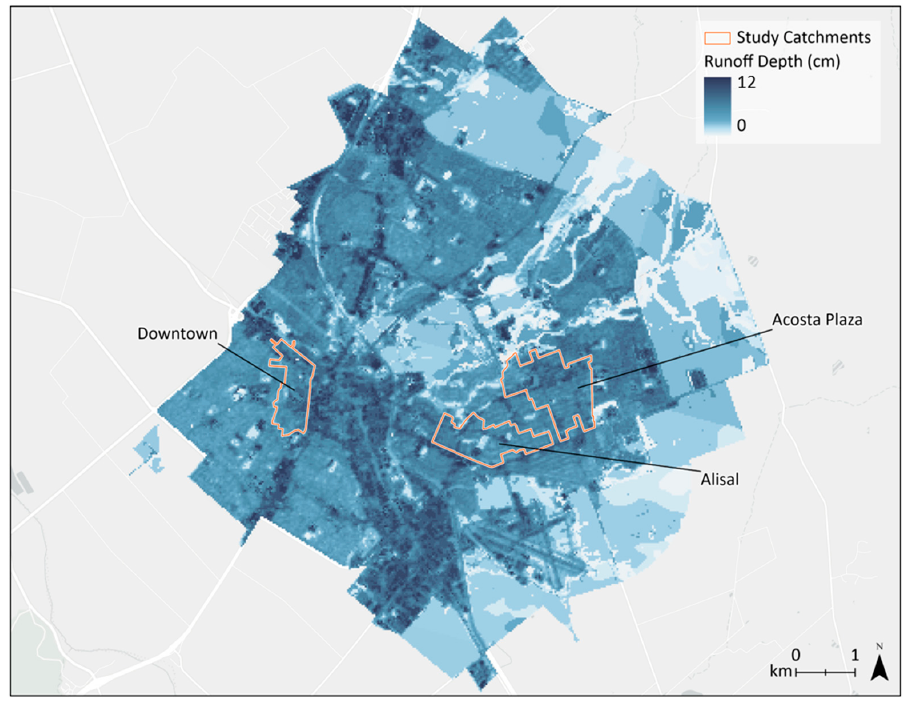
Figure 5. The swTELR average annual runoff depth estimates for City of Salinas for water years 2018–2020.